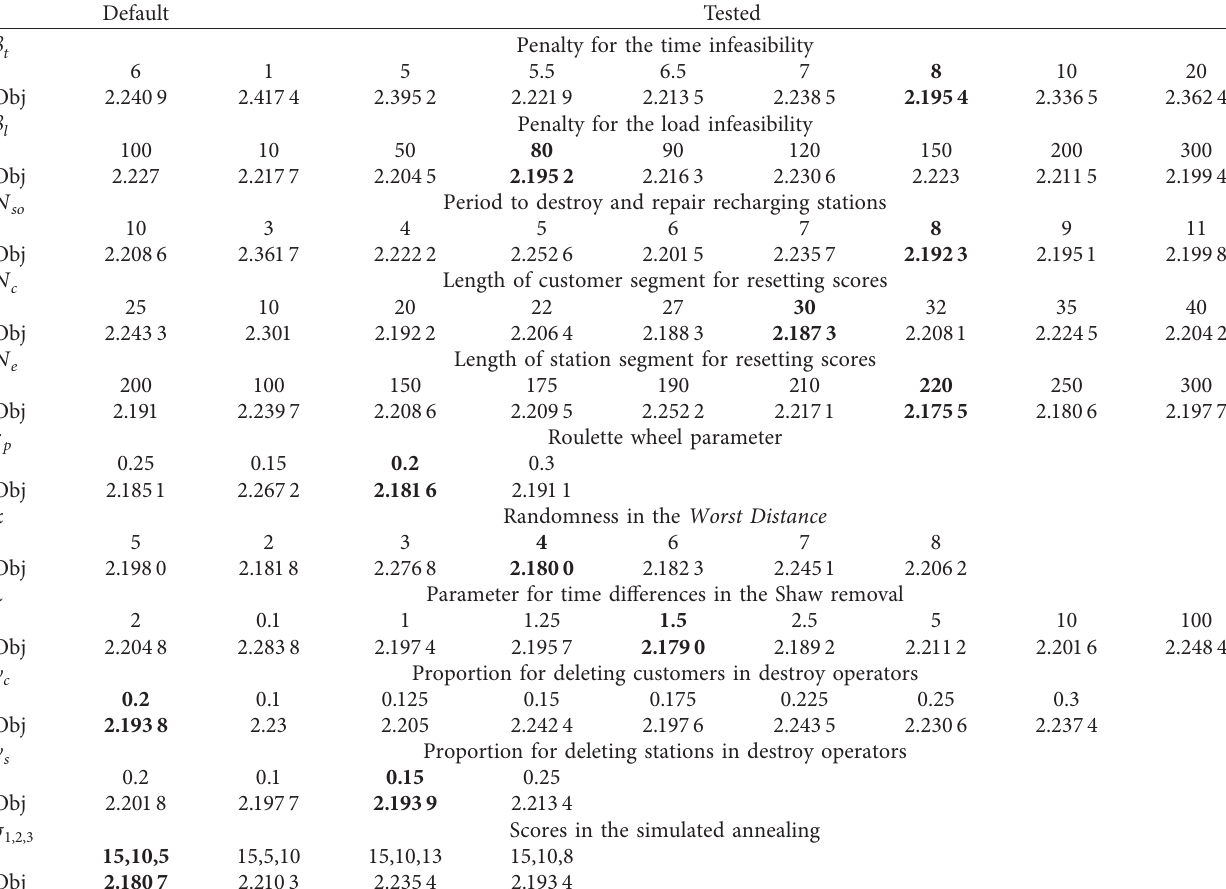
Table 2: Results of parameter tuning (Obj ∗ 10 4